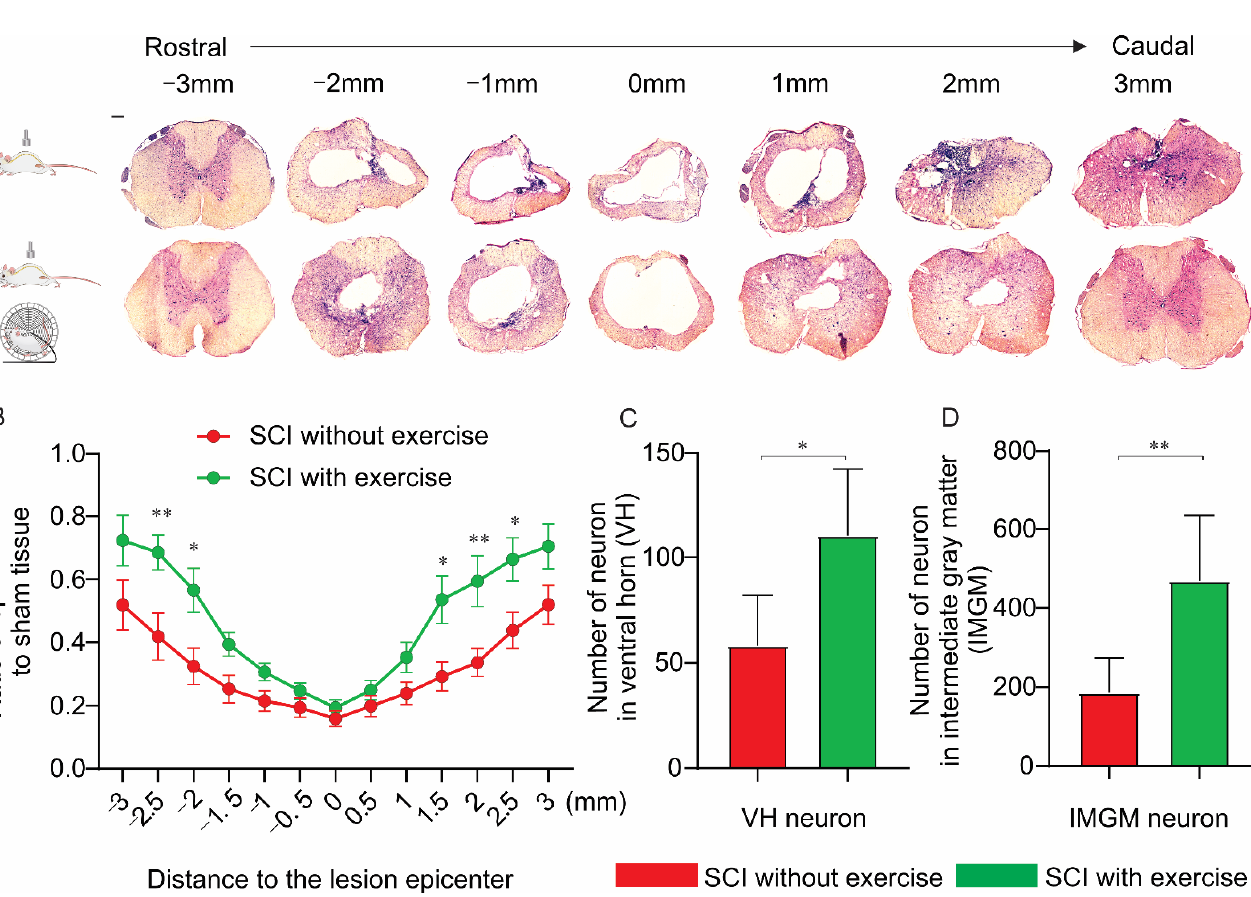
12 of 21 Figure 5 . Locomotor exercise ameliorates bladder morphology. ( A , C , E ) Cross-sections of bladder stained with Masson’s trichrome in low magnification. ( B , D , F ) Areas within red dashed rectangles in high magnification. Red, muscle fibers; blue, collagen. ( G ) SCI increased the collagen/muscle ratio while exercise reduced this ratio. ( H ) SCI induced hypertrophy of bladder wall, but exercise re- versed hypertrophy. *: p < 0.05; ***: p < 0.001. Scale bar 500 μ m. 3.5. Locomotor Exercise Increases the Extent of Spared Spinal-cord Tissue To assess whether locomotor exercise promotes neuroprotection following injury, histological analysis was utilized. In the lesion epicenter, there was no difference between the spared tissue of the exercise and no-exercise groups. At 2.5 mm ( p < 0.01) and 2 mm ( p